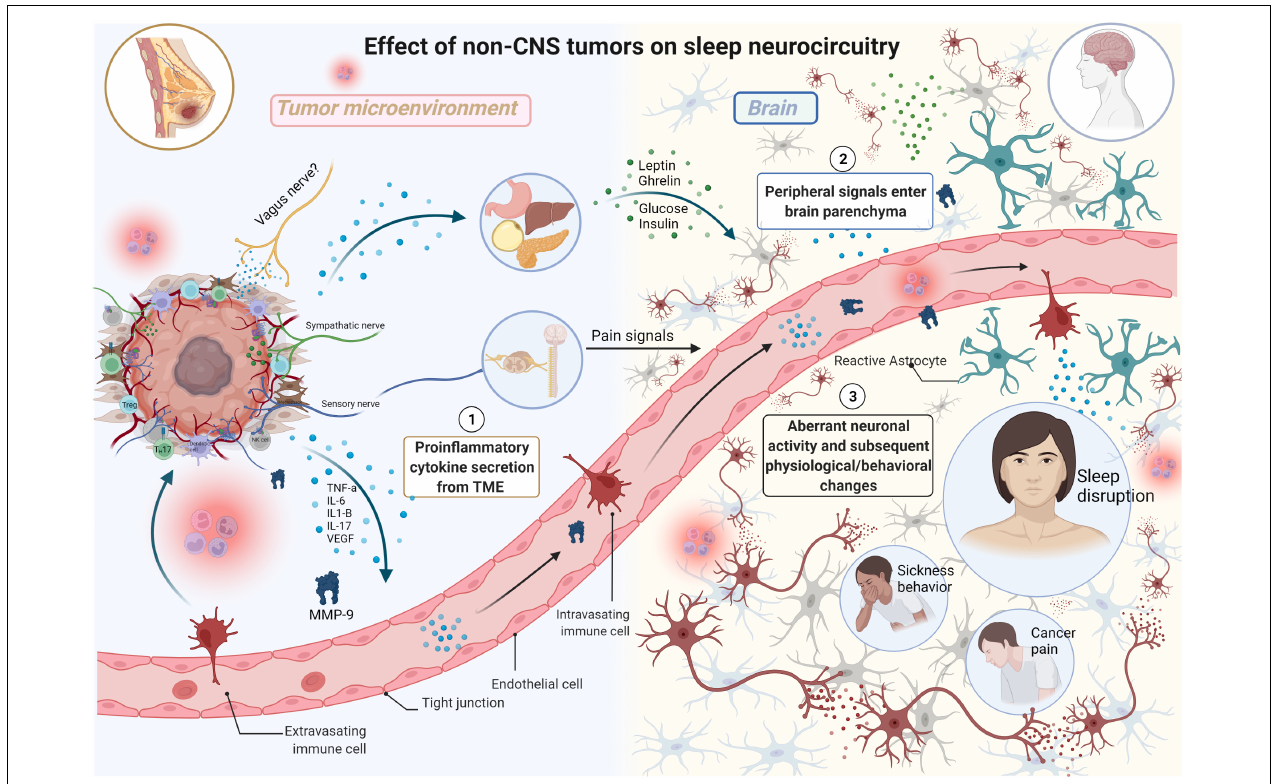
FIGURE 2 | The effects of non-CNS tumors on sleep neurocircuitry. TME-derived proinflammatory signals (e.g., TNFa, IL-6, IL1-B, IL-17) enter systemic circulation, eventually moving into the brain parenchyma impacting neurocircuitry including sleep. TME-derived proinflammatory signals also exert effects on distant organs including stomach, liver, pancreas, and adipose tissue resulting in elevated secretion of satiety/hunger hormones (e.g., leptin, ghrelin) and glucose and insulin which all exert differential effects on sleep neurocircuitry in the CNS. Sensory nerves in the TME relay information from the TME, resulting in the production of severe pain in various malignancies including breast cancer. This results in neurochemical changes in the spinal cord and forebrain, including elevated levels of noradrenaline (NA), in the brain parenchyma with negative consequences on both quality of life and survival. Aberrant neuronal activity results in subsequent physiological/behavioral changes including sleep disruption, sickness behavior, and cancer pain (Made with